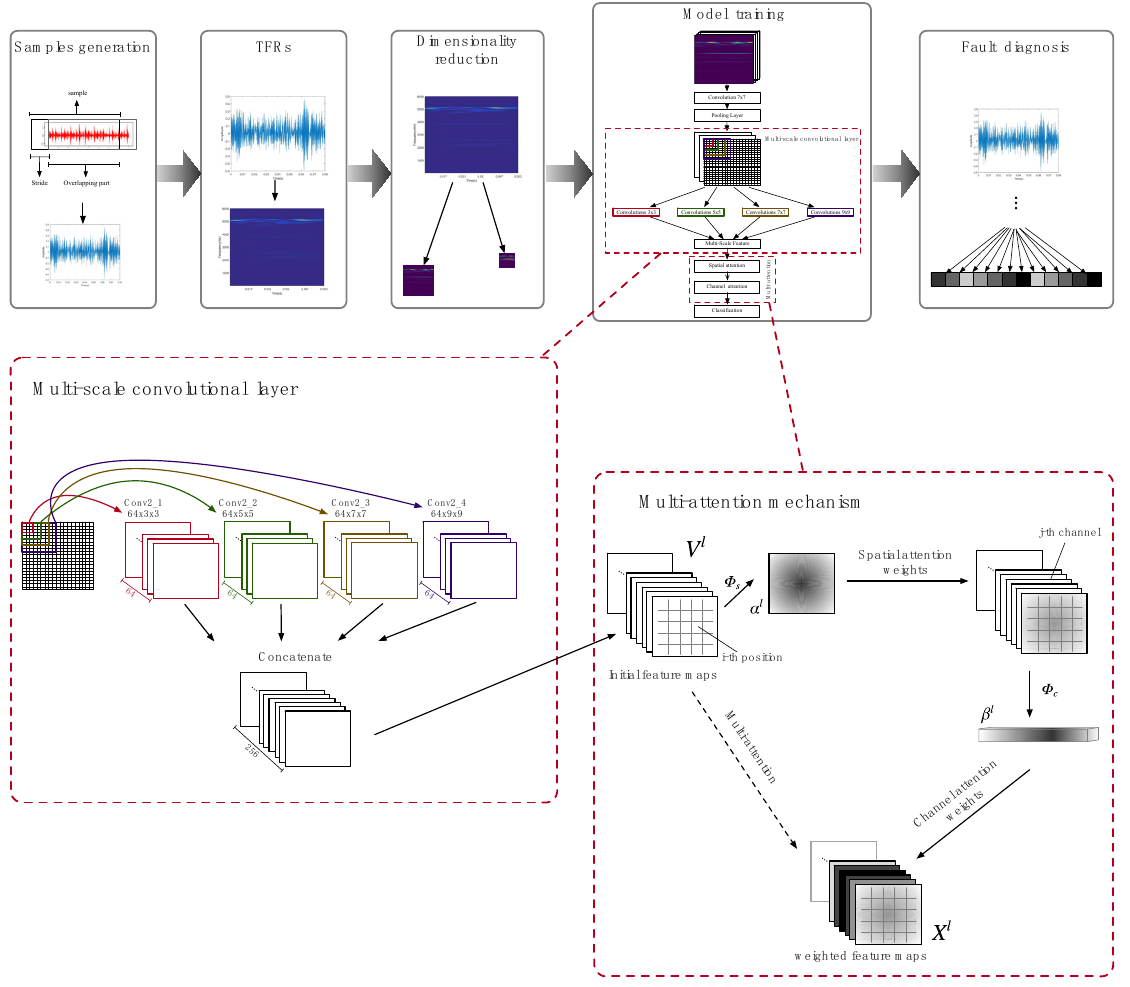
Figure 1. Framework of the proposed fault diagnosis method and structure of the multi-scale convolutional neural network with a multi-attention mechanism.